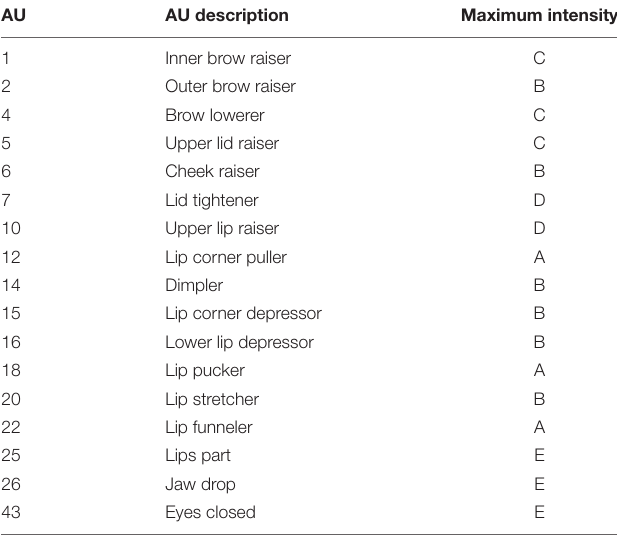
TABLE 2 | Results of the Facial Action Coding System (FACS) coding of Nikola’s facial actions. AU AU